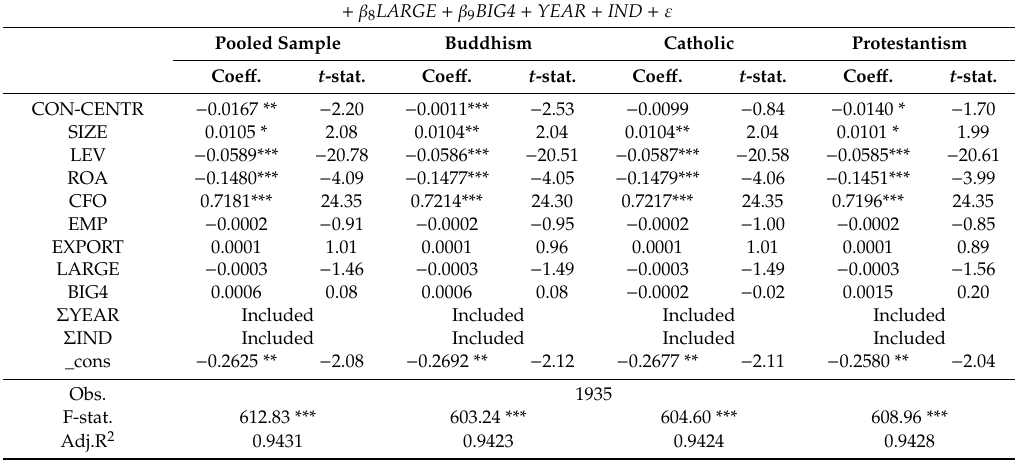
Table 5. The e ff ects of directors’ religious concentration on tax avoidance of